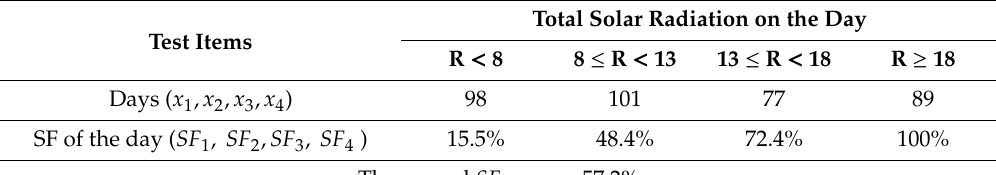
Table 9. The solar fraction (SF) field test and calculation for Shanghai Shanxiang project.